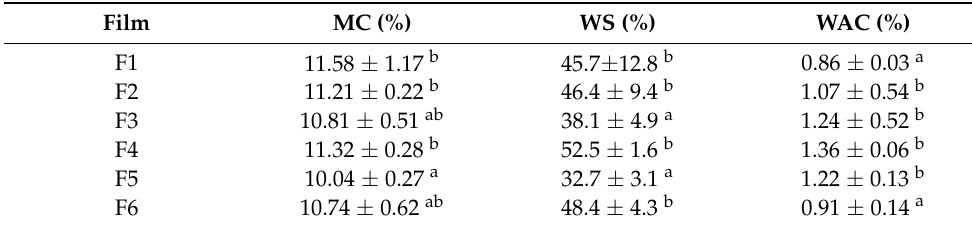
Table 3. Moisture content (MC), water solubility (WS), and water absorption capacity (WAC) of the